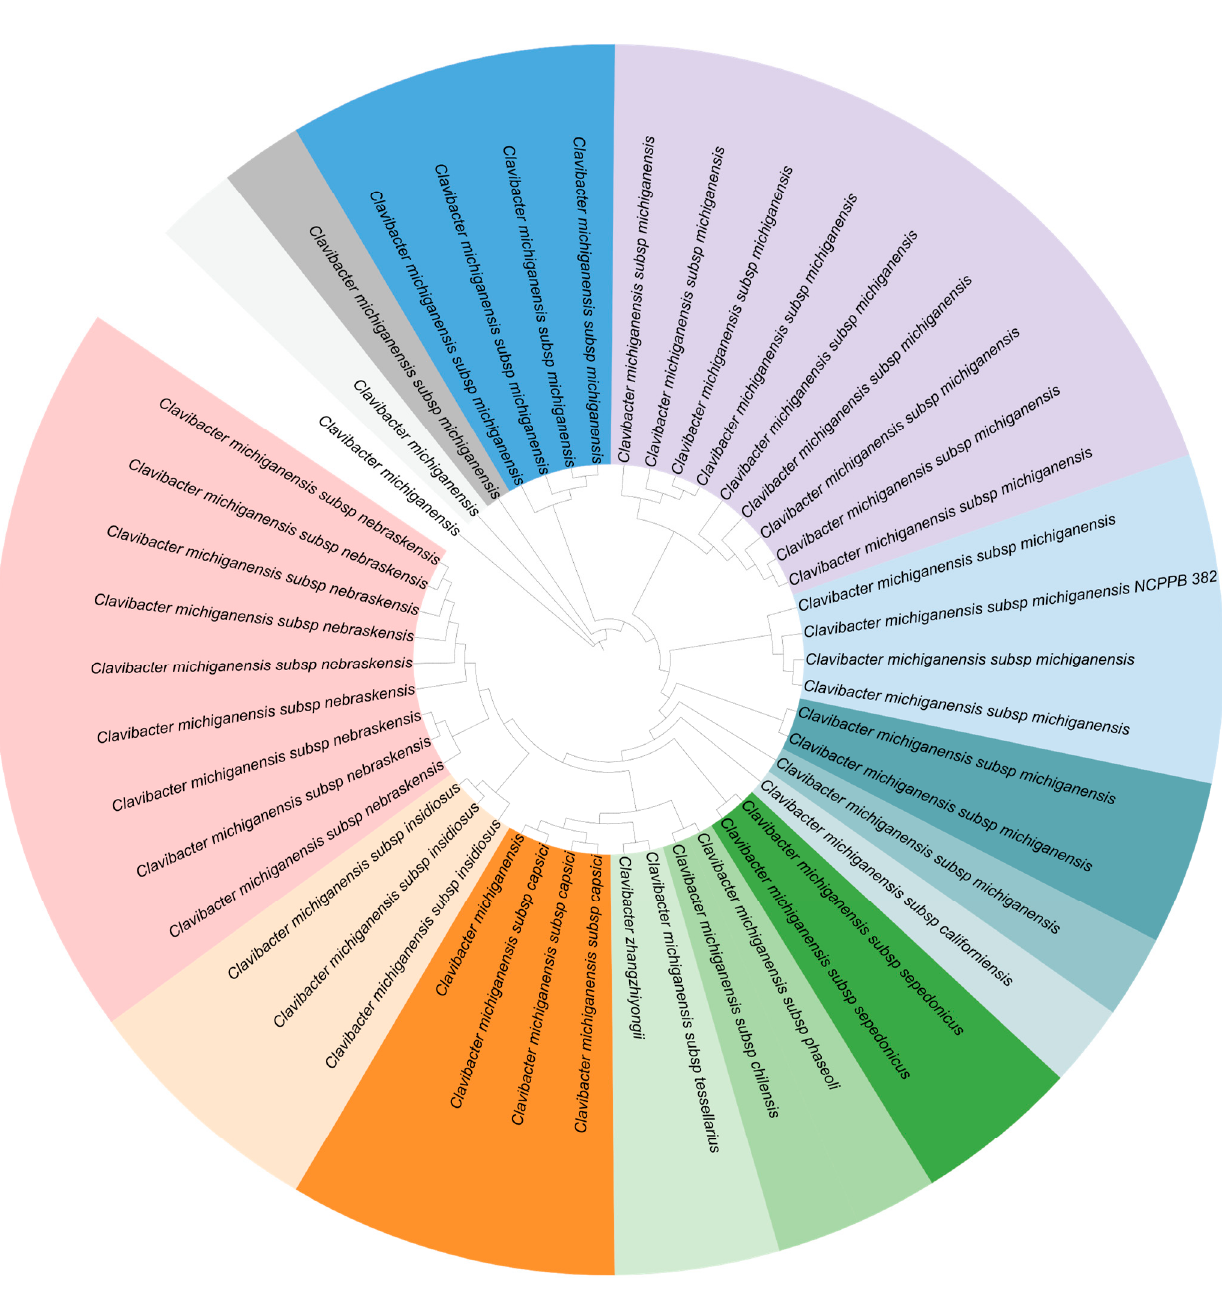
Figure 2. A genome-based phylogenetic tree based on 46 complete genome sequences of the genus Clavibacter . The tree was constructed with the Bacterial and Viral Bioinformatics Resource Center (BV-BRC) [24]. Only Clavibacter strains that have chromosome-level genome assembly were selected for analysis. The tree was visualized by using ITOL [25].